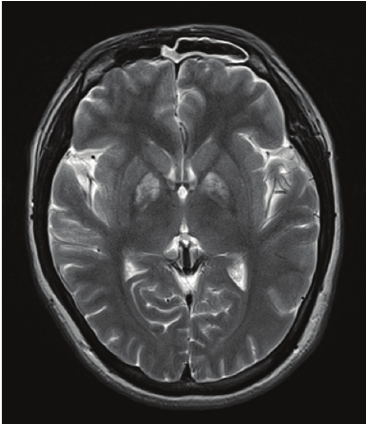
Figure 3: Axial T2-weighted MRI image in a patient with severe methemoglobinemia shows increased signal intensity bilaterally in the globus